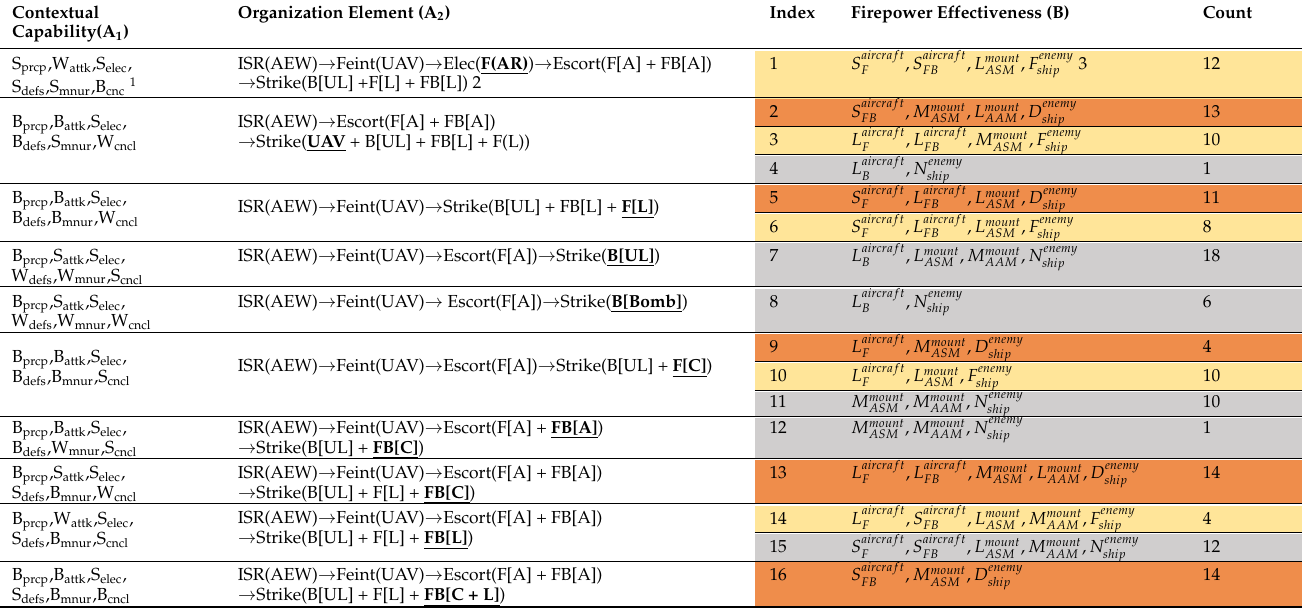
Table 5. Discovered organization preference knowledge of